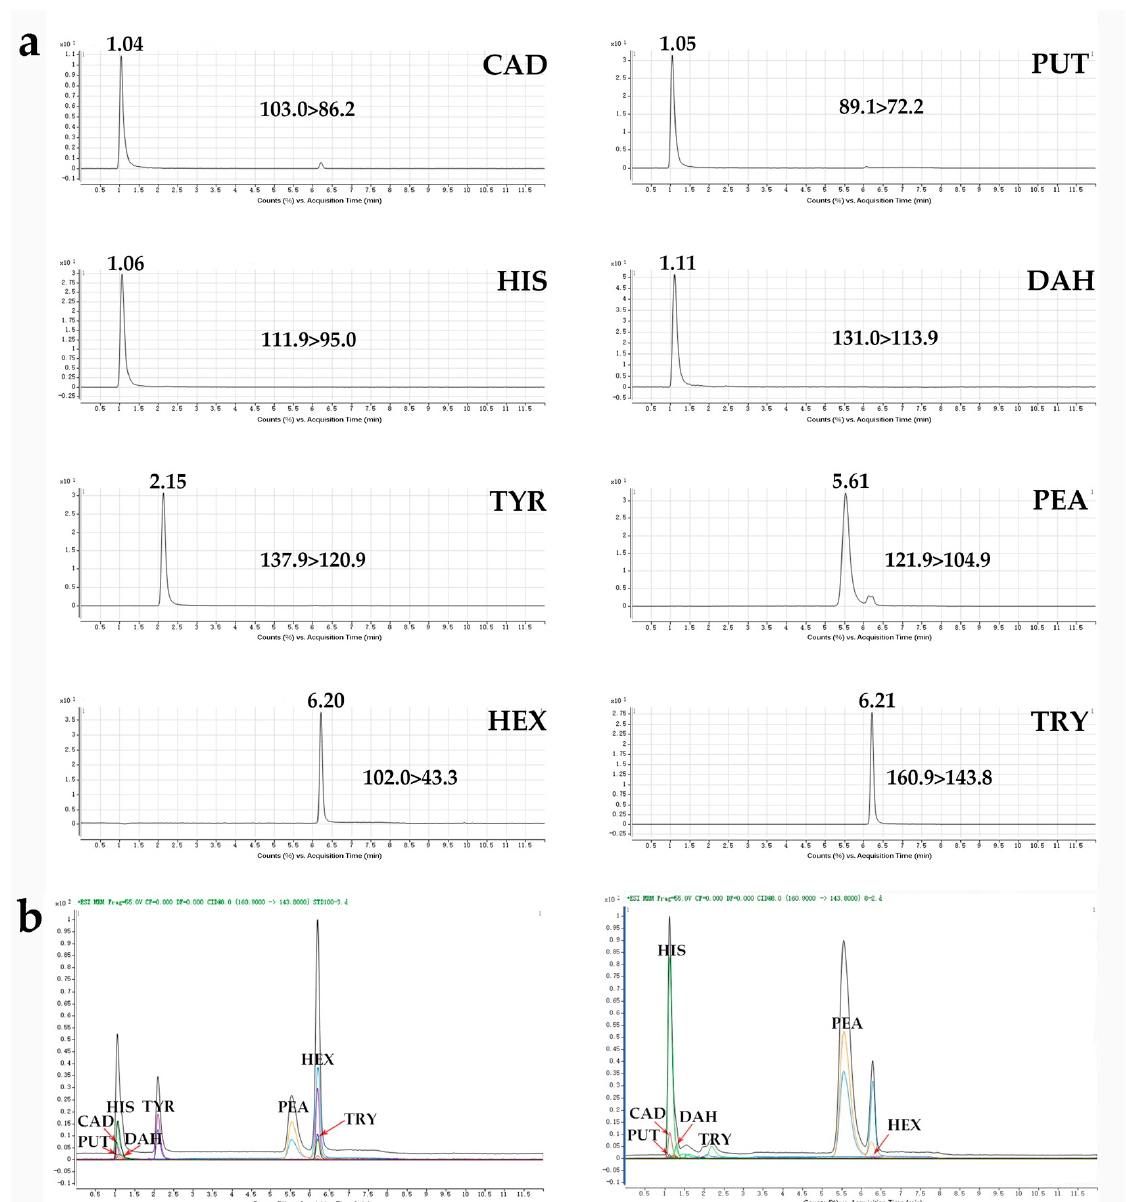
Figure 2. The extracted ion chromatograms of seven biogenic amines (BAs) and the internal standard in a standard solution under positive mode ( a ), and total ion chromatograms and extracted overlaid dynamic multiple reaction monitoring (DMRM) chromatograms obtained from ultra-performance liquid chromatography coupled to a triple quadrupole mass spectrometry (UHPLC-QqQ-MS/MS) analysis in full-scan mode ( b ), (left) standard solution; (right) real wine sample (CAD: Cadaverine; PUT: Putrescine; HIS: Histamine; DAH: 1,7-diaminoheptane; TYR: Tyramine; PEA: Phenylethylamine; HEX: Hexylamine; TRY: Tryptamine).